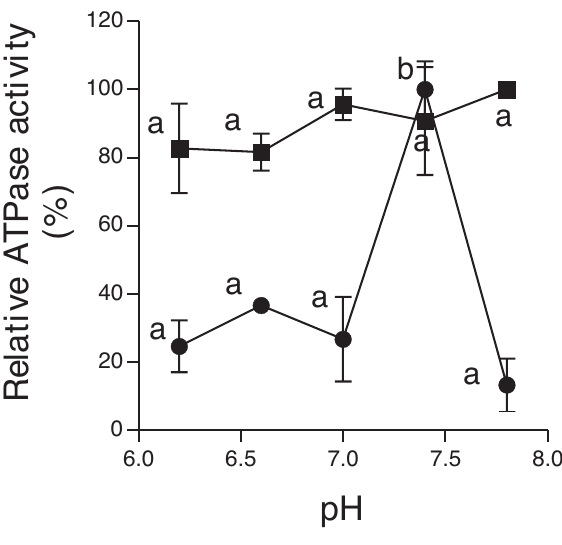
f ig . 2. – effect of pH on na + -K + atPase activity in chela muscle of C. angulatus . the values of na + -K + atPase activity and residual (Mg 2+ -na + ) atPase activity are expressed as a relation to the activ- ity at pH 7.4 (100%, na + -K + atPase activity: 66.3 ± 5.5 and (Mg 2+ - na + ) atPase activity: 110 ± 28.6 nmoles Pi x min -1 x mg prot -1 ). in some cases, deviation bars were smaller than the symbols used. data are the mean ± S.e. for three individuals. Circles: na + -K + atPase activity. Squares: residual (Mg 2+ -na + ) atPase activity. different